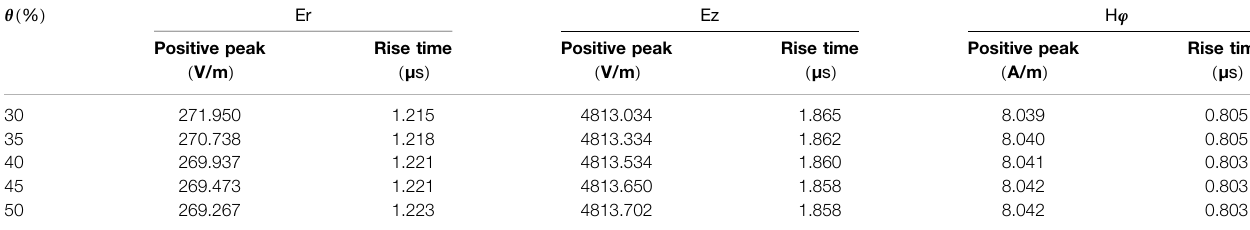
TABLE 3 | Same as Table 2 but for different porosities φ when the water content θ (cid:2) 15%. θ ( %